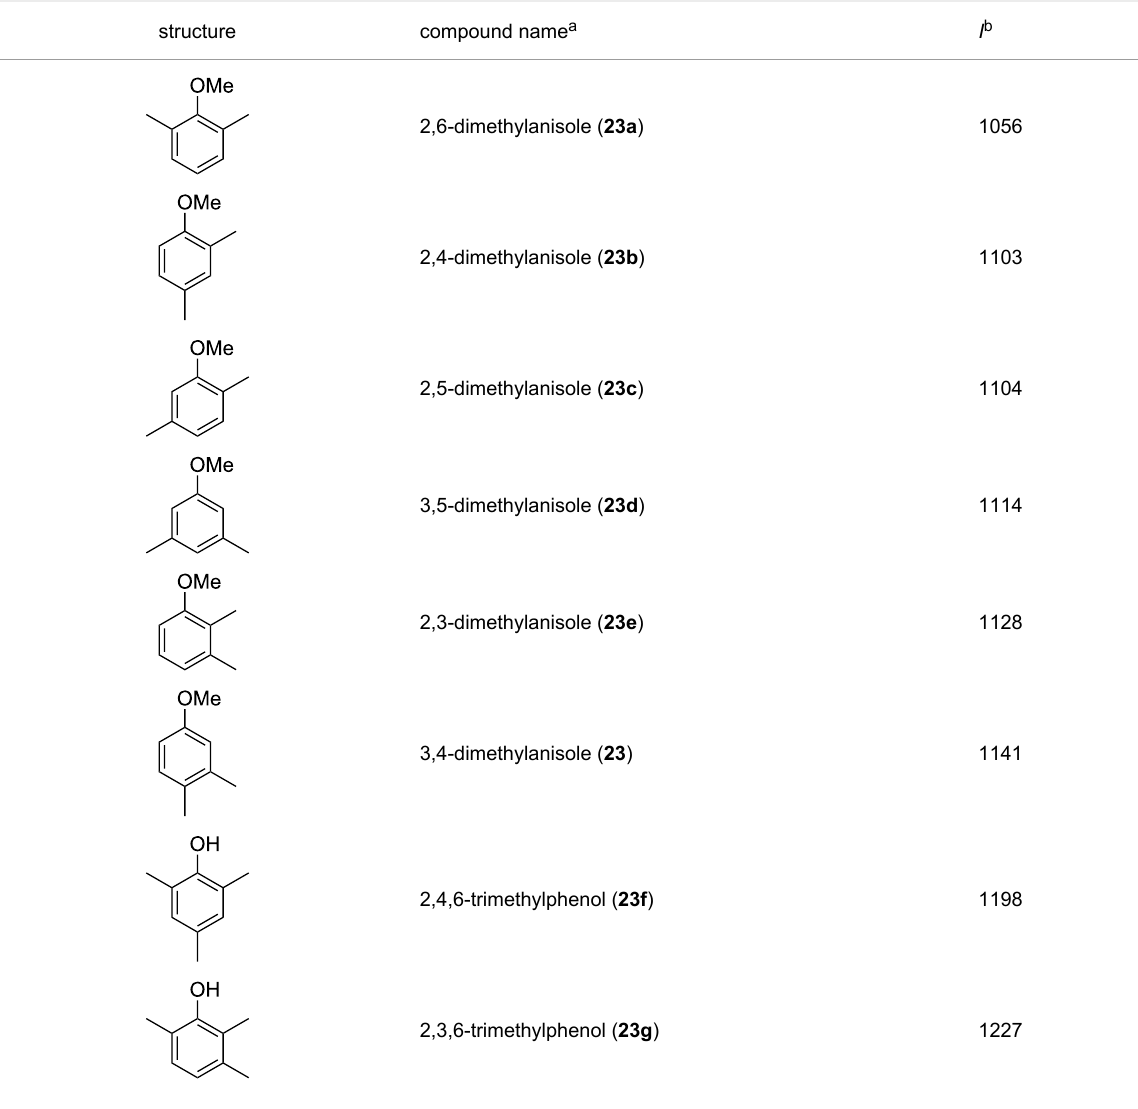
Table 3: Retention indices of all isomers of dimethylanisole and